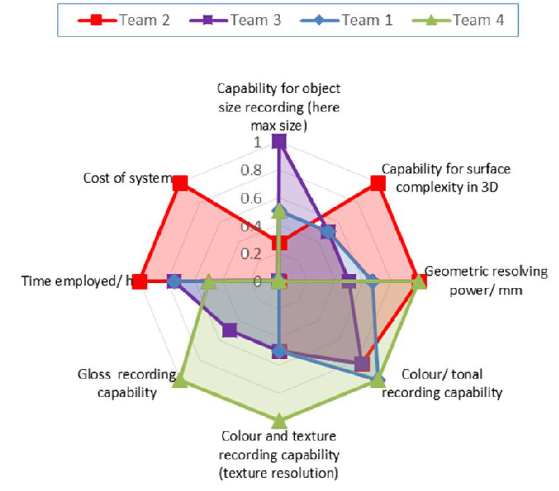
Figure 20 Sensor criteria (normalized) are echoing the user requirements in Figure